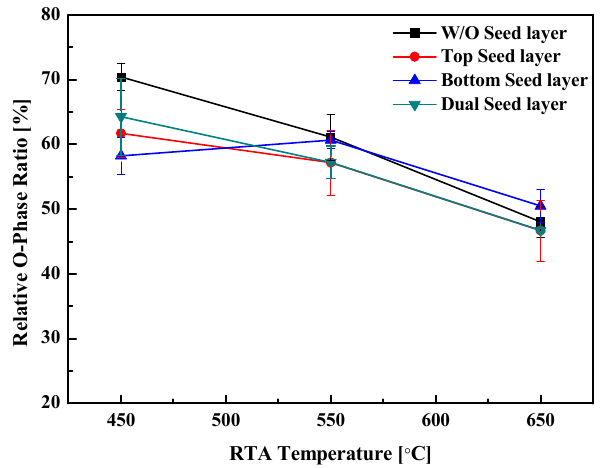
Figure 8. Relative ratio of the O/T/C phase of the four types of specimens according to the application of the seed layer.